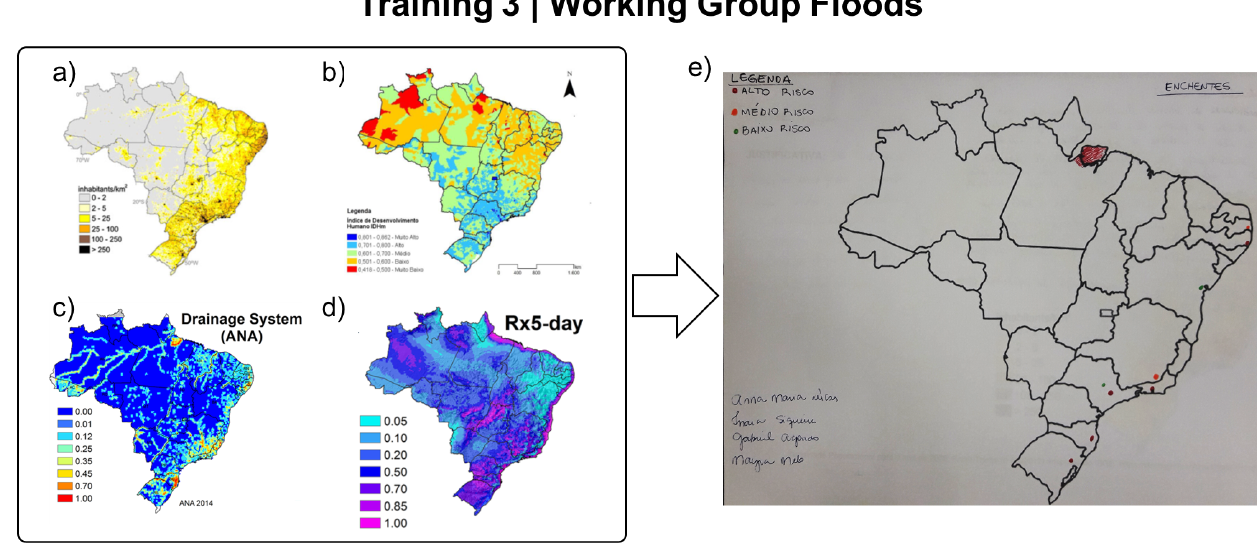
Figure A11. Package of maps used in the third training for mapping climate risk associated with floods. The maps illustrate (a) Brazilian population density (Torres et al., 2012), (b) Human Development Index (HDI; MMA 2017), (c) watershed drainage (Debortoli et al., 2017), (d) maximum consecutive 5d precipitation (Rx5-day; Debortoli et al., 2017), and (e) the climate risk map drawn by the participants.